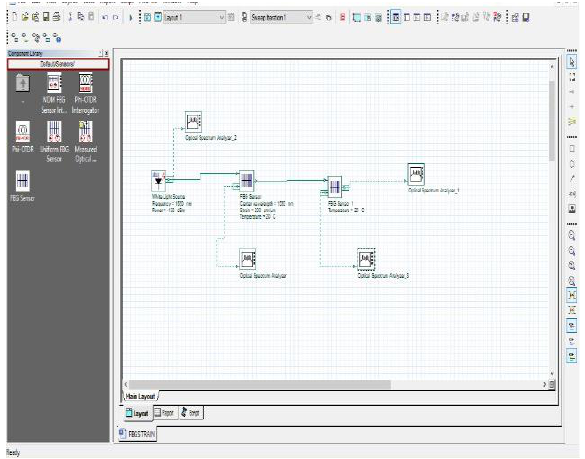
Fig. 3. A simplified architecture of fiber optic sensor